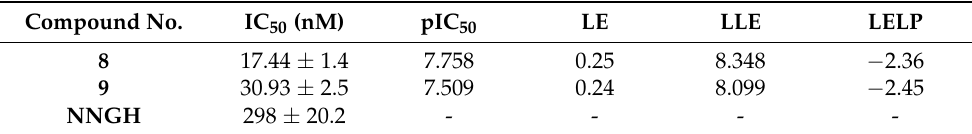
Table 4. In vitro MMP-2 inhibitory activities of 8 and 9 and their ligand efficiency metrics. Compound No.